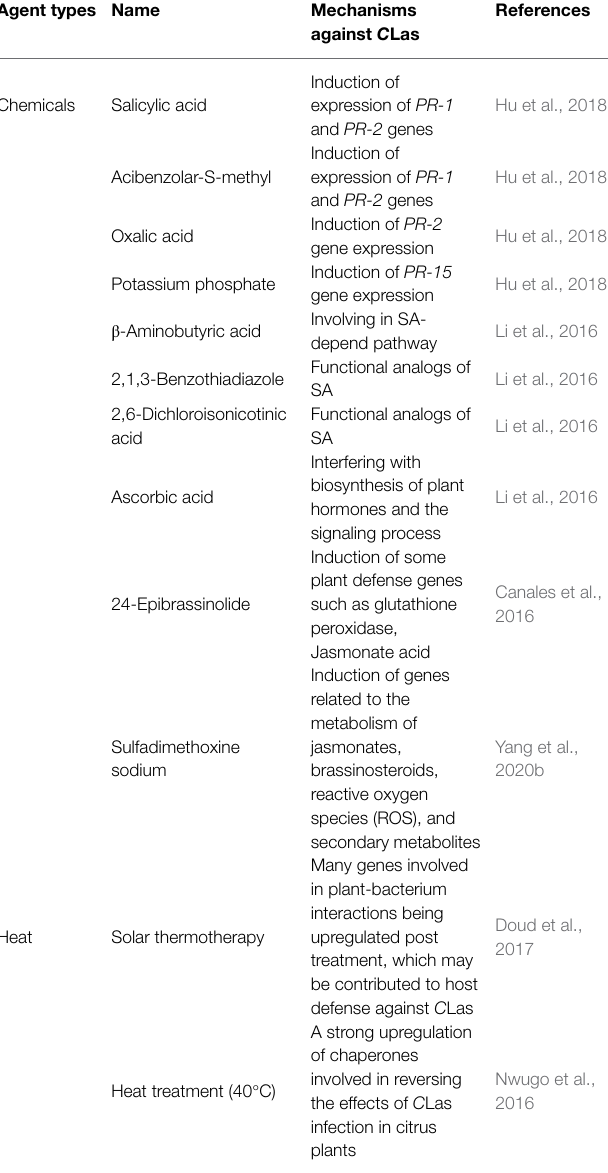
TABLE 3 | Chemicals and heat activate citrus defense